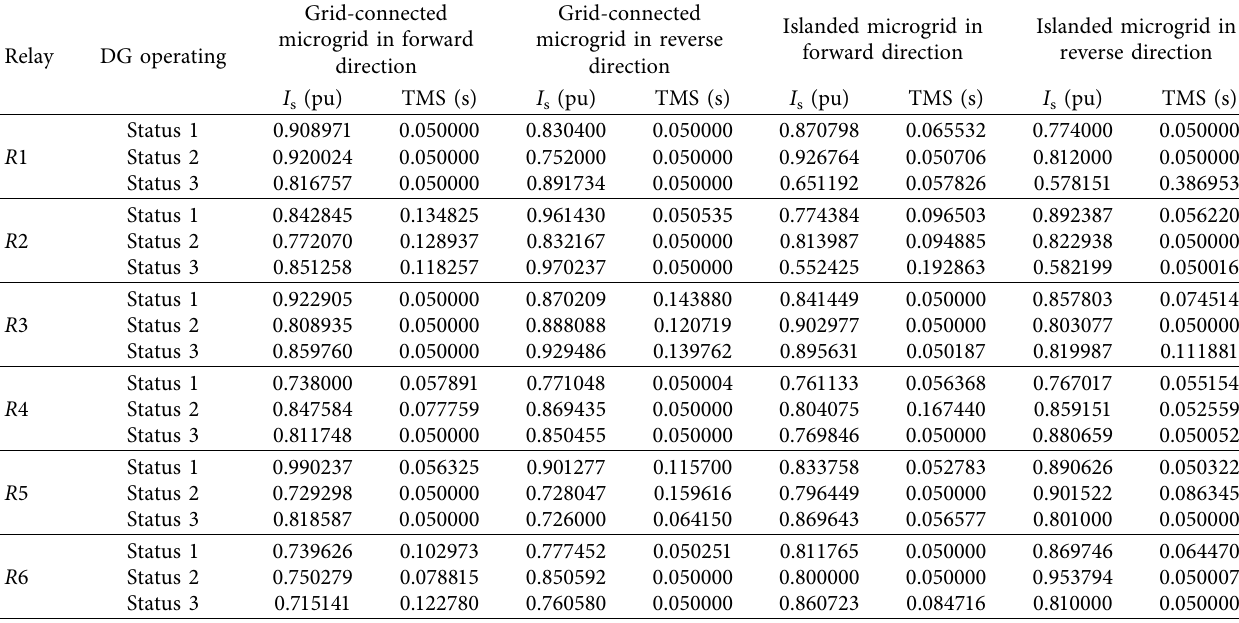
Table 9: Dual-directional overcurrent relay settings for the quaternary protection coordination scheme.